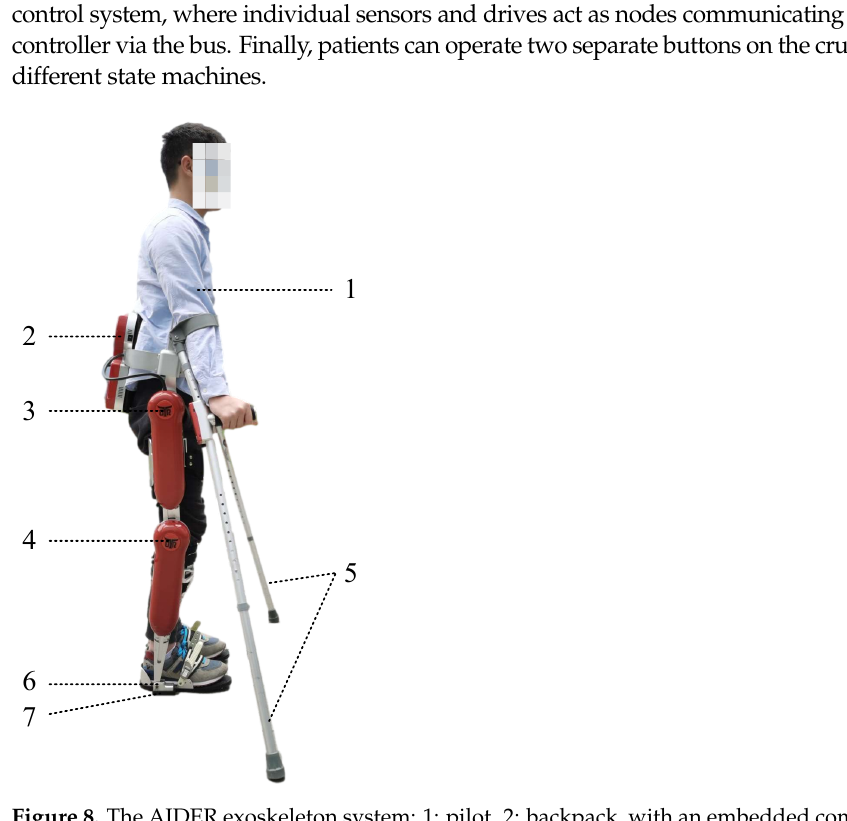
Figure 8. The AIDER exoskeleton system: 1: pilot. 2: backpack, with an embedded computer. 3 and 4: hip and knee flexion/extension joint activated by dc servo motors. 5: crutches. 6: passive ankle flexion/extension joint. 7: shoes with plantar pressure sensors inside.